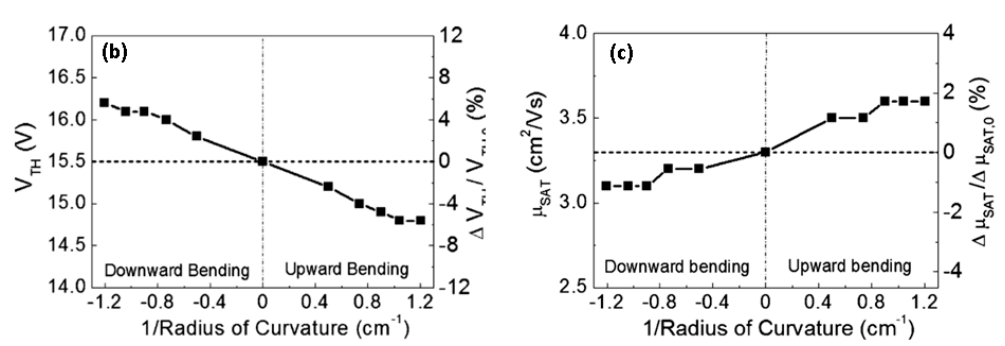
Figure 14. ( a ) variation of compressive and tensile strain with inverse bending radius [162], variations in V TH ( b ) and μ sat ( c ) and their percentage variations [81].